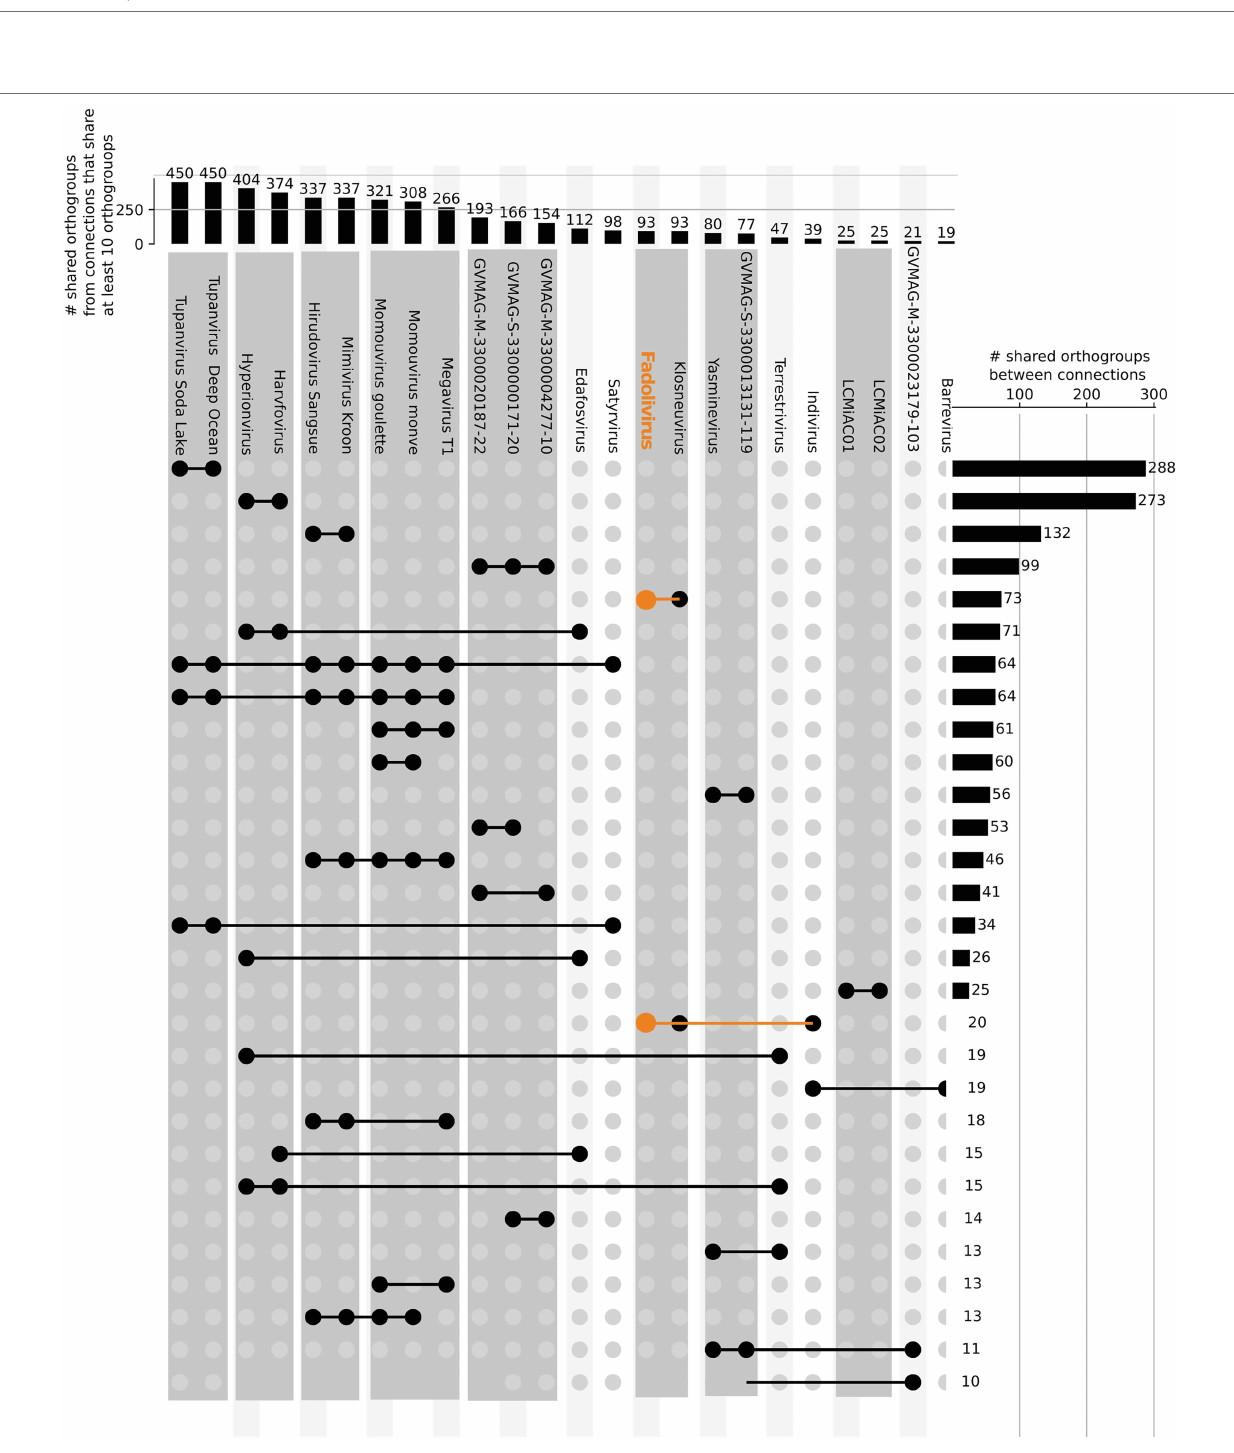
FIGURE 5 | are present in Fadolivirus and its closest relatives but absent in other members of the Mimiviridae; and protein families that are present in more than 30% of viral genomes in the Mimiviridae but not in Fadolivirus and its closest relatives. Stacked bars show the total count and annotation of pfam domains present in each of these protein families.